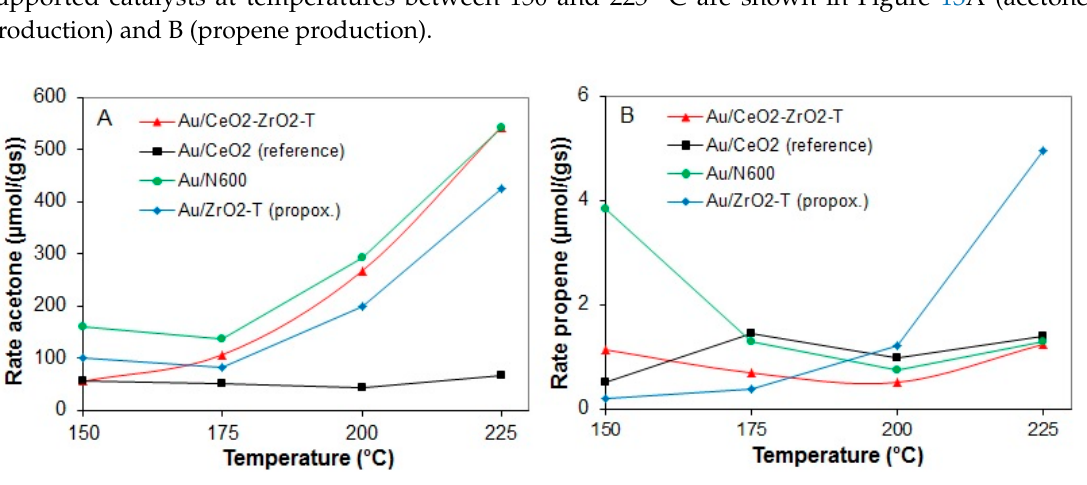
Figure 13. Rates of acetone production (A) and propene production (B) at 150 to 225 °C for various pre-treated gold supported catalysts.